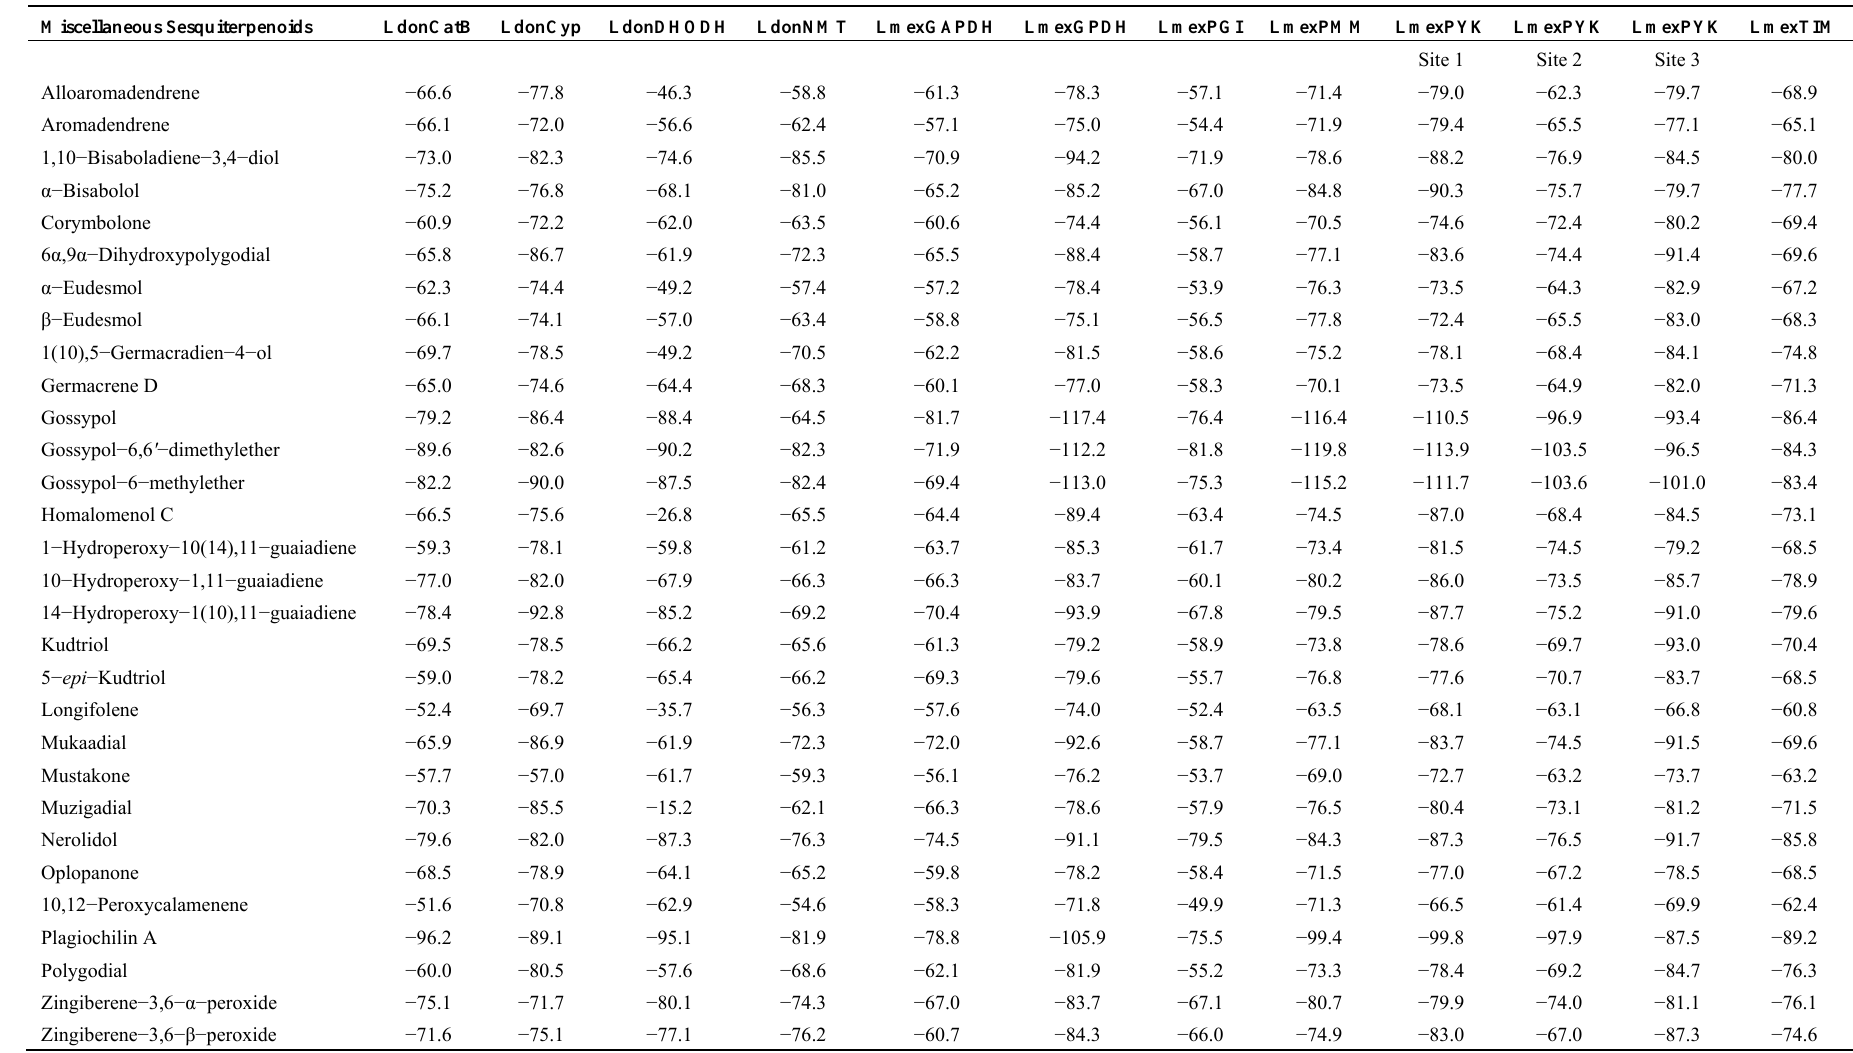
Table 14. MolDock docking energies (kJ/mol) of miscellaneous sesquiterpenoids with Leishmania donovani and L. mexicana protein